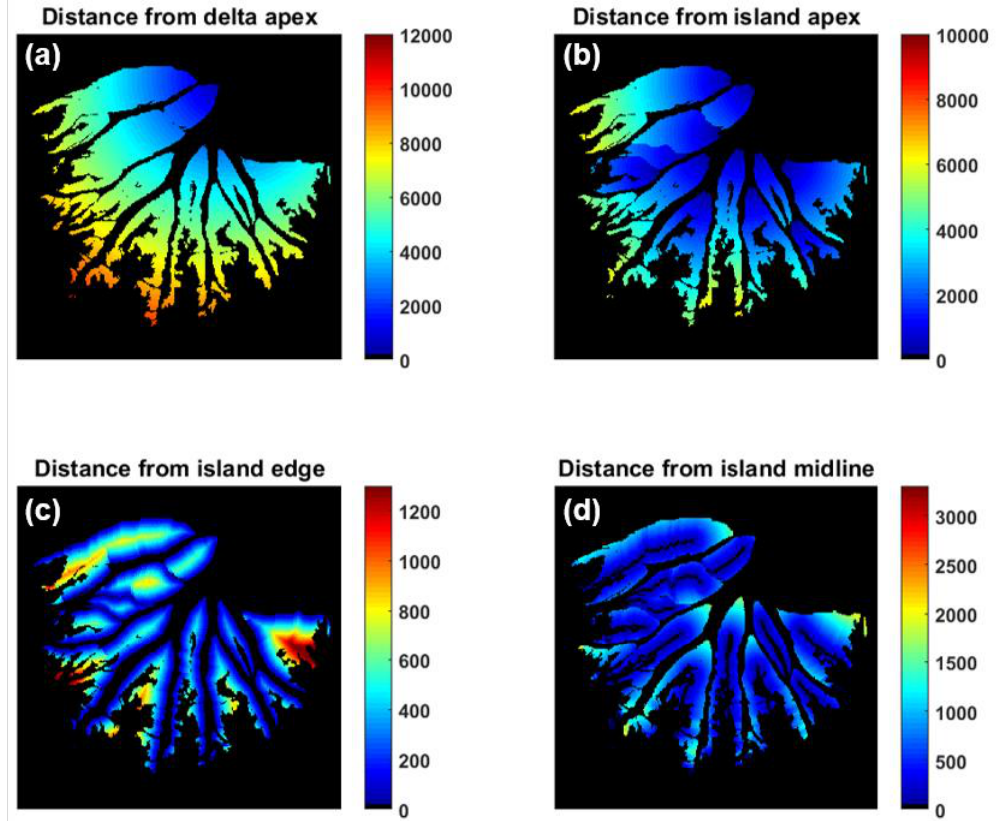
Figure 3. Example geometric position maps. Distance of each marsh pixel in the delta to ( a ) the delta apex, ( b ) its island’s apex, ( c ) its island’s nearest channel edge, ( d ) its island’s central axis (i.e., midline, starting ¼ of the way down the island from the island apex). Units for each variable are meters. Examples shown for the 2011 – 2013 timeframe.